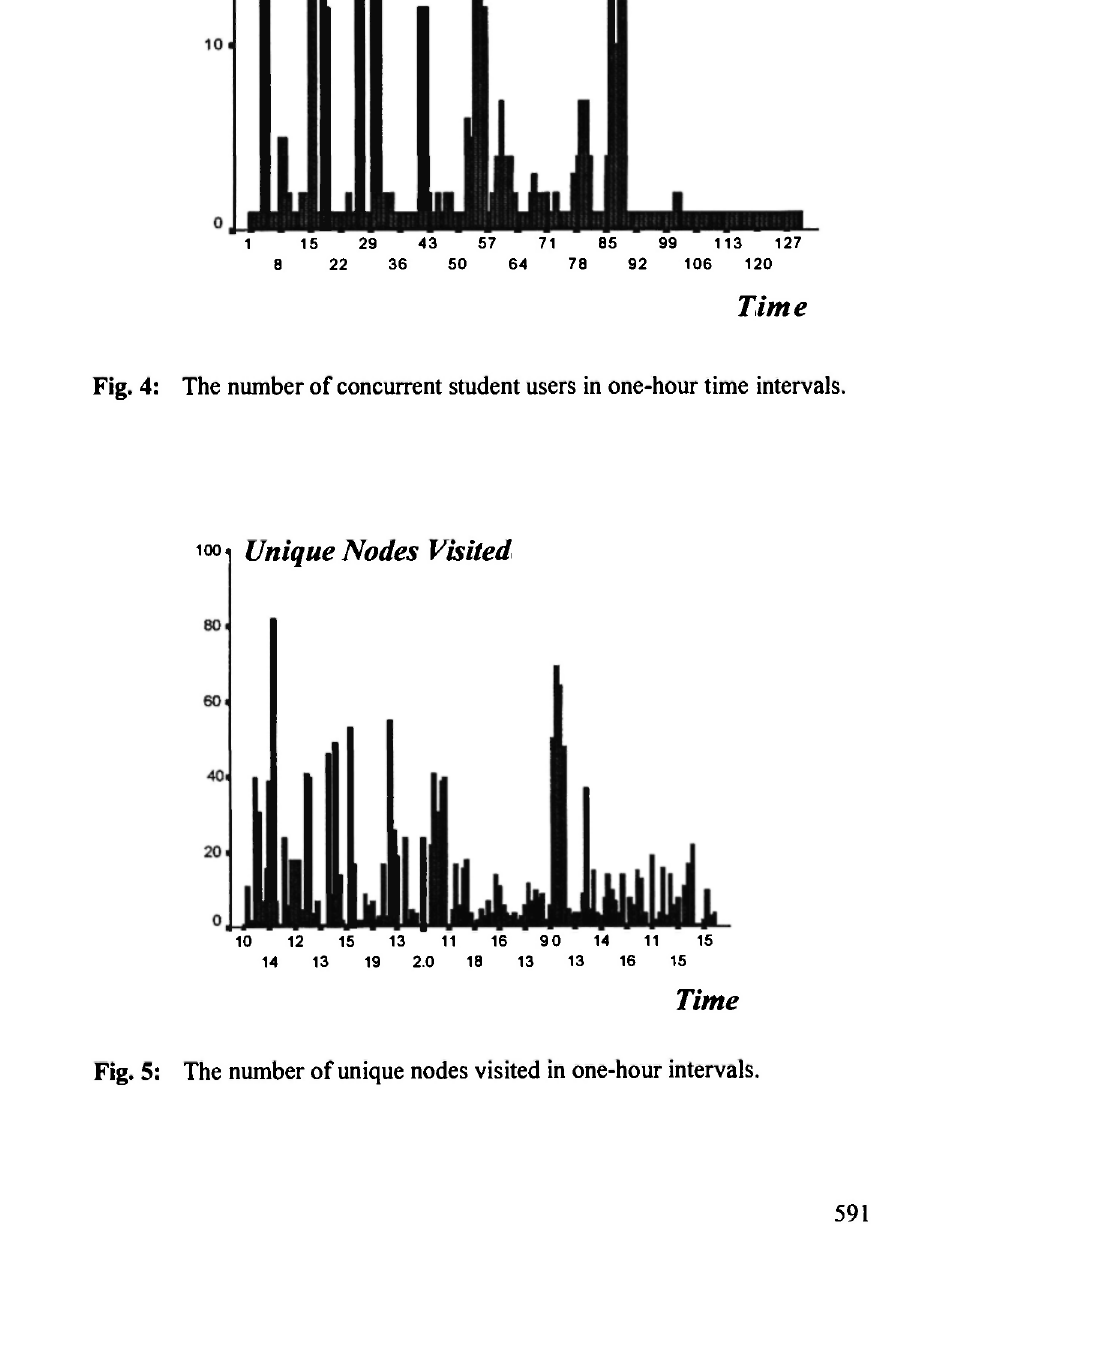
Fig. 4: The number of concurrent student users in one-hour time intervals.